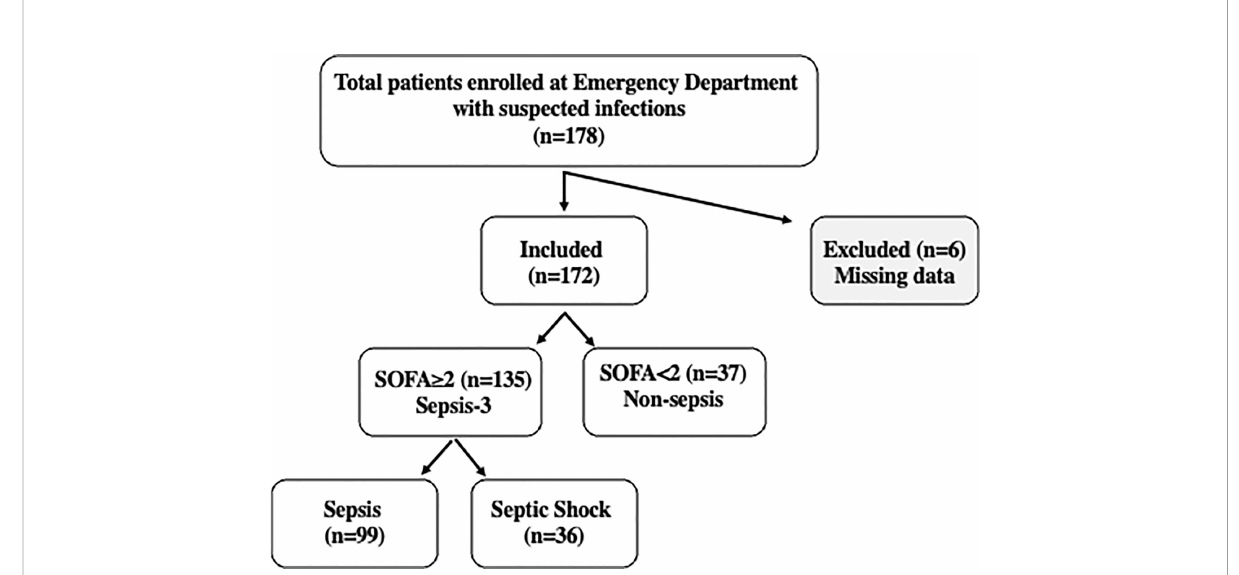
FIGURE 1 Flowchart of the study. A cohort of 178 patients was enrolled at the Emergency Department of Humanitas Research Hospital with suspected sepsis. 172 patients were included in the study and strati fi ed based on Sepsis-3 criteria. Patients with SOFA<2 were classi fi ed as “ non-sepsis ” (n=37), while the 135 patients with SOFA ‗ 2, were classi fi ed as “ sepsis ” (n=99) or “ septic shock ” (n=36) according to clinical evaluation. Septic shock patients were characterized by vasopressor requirement to maintain a mean arterial blood pressure of 65 mmHg or greater and serum lactate levels >2mm/L in the absence of hypovolemia or altered mentation (Glasgow coma scale score <